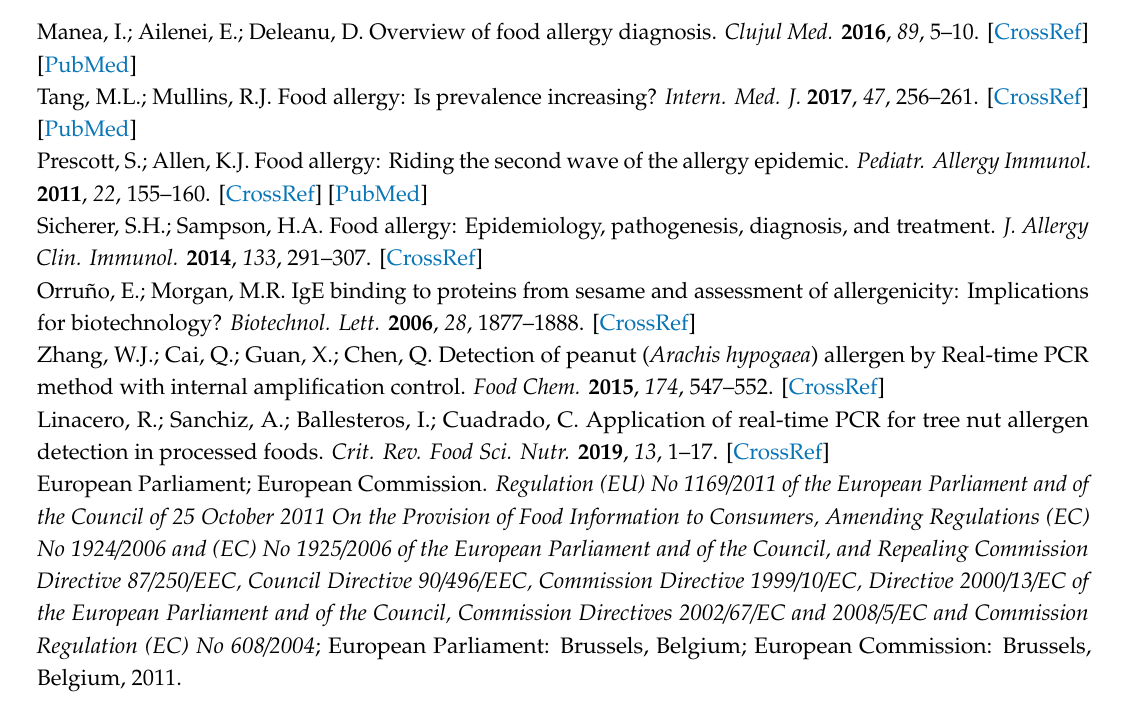
Supplementary Table S1: Inhibition test for allergen targets and samples used for specificity, Supplementary Table S2: Data of mean Cq, repeatability standard deviation (SDr) and ∆ Rn for sesame, macadamia nut and pistachio (a–b) of primer and probe optimisation assays, Supplementary Table S3: Data relative to LOD 95 for sesame, macadamia nut and pistachio